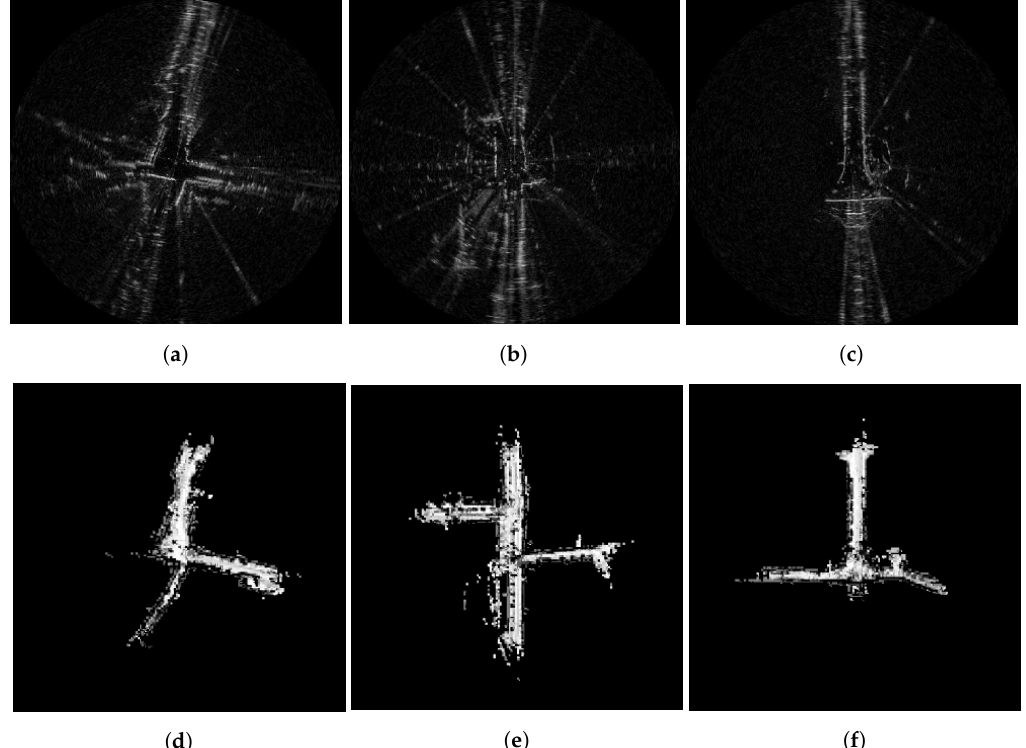
Figure 9. Radar scans ( top ) and corresponding traversability labels ( bottom ) captured and computed in three places where the road layout features junctions. In the left example ( a , d ), the autonomous vehicle (AV) survey vehicle travels south-to-north along the vertically running stretch of road and sparse LiDAR measurements are accumulated along the resulting pose chain. In the middle example ( b , e ), the two east-to-west junctions are visited at later times and the pose chain consists of loop closures which allow the LiDAR measurements from later times to feature in the current volume. In the right example ( c , f ), however, there is never any revisit to the south road section. As such, no LiDAR points are accumulated